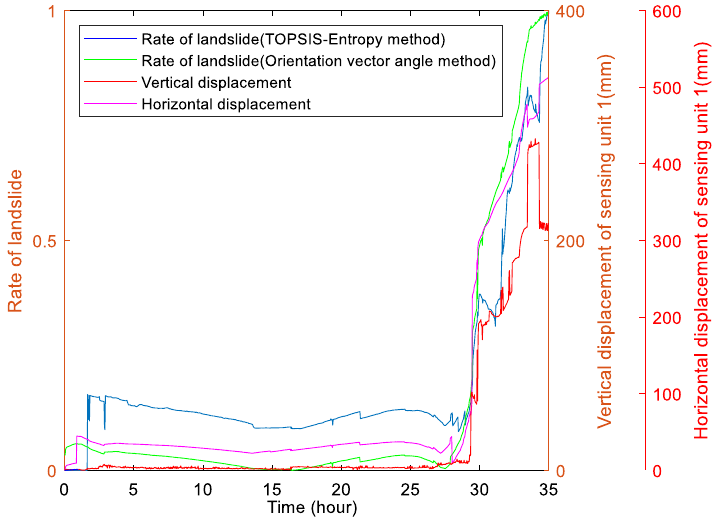
Figure 18. The curve of danger rate of landslide.